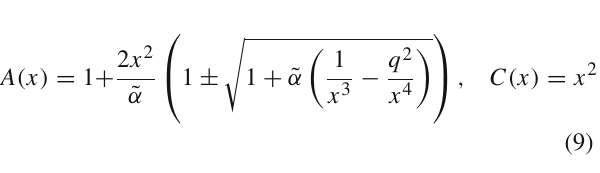
Fig. 1 The parameter space ( q , ˜ α ) for the existence of black hole hori- zons; black solid line corresponds to the values of parameters for which extremal black hole exists